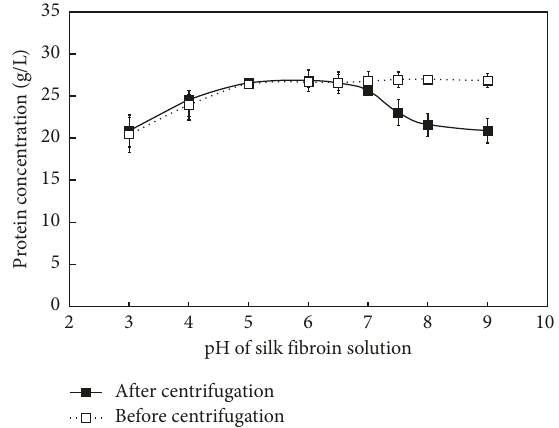
Figure 1: Effect of pH on the solubility of regenerated silk fibroin in 0.25M citrate-phosphate